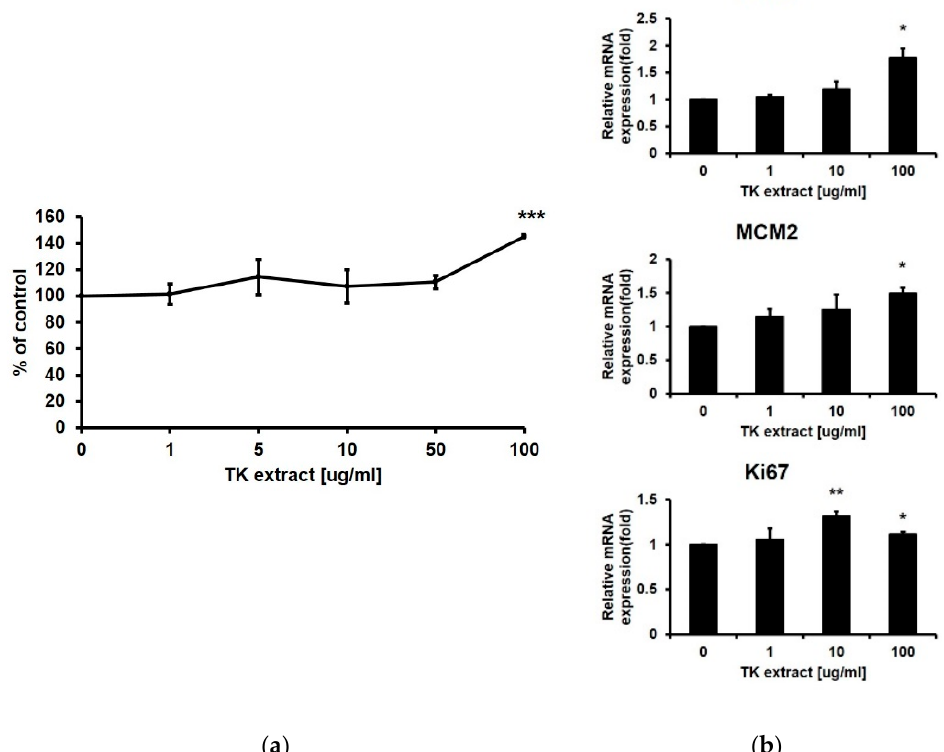
Figure 1. Trichosanthes kirilowii (TK) extract induced the proliferation of HaCaT cells. ( a ) HaCaT cells were treated with indicated concentrations of TK extract. The cell proliferation rate was evaluated based on the MTT assay. (***: p < 0.001.) ( b ) TK extract dose-dependently increased the mRNA expression of proliferation marker genes in HaCaT cells based on the qRT-PCR analysis. (*: p < 0.05, **: p < 0.01.)